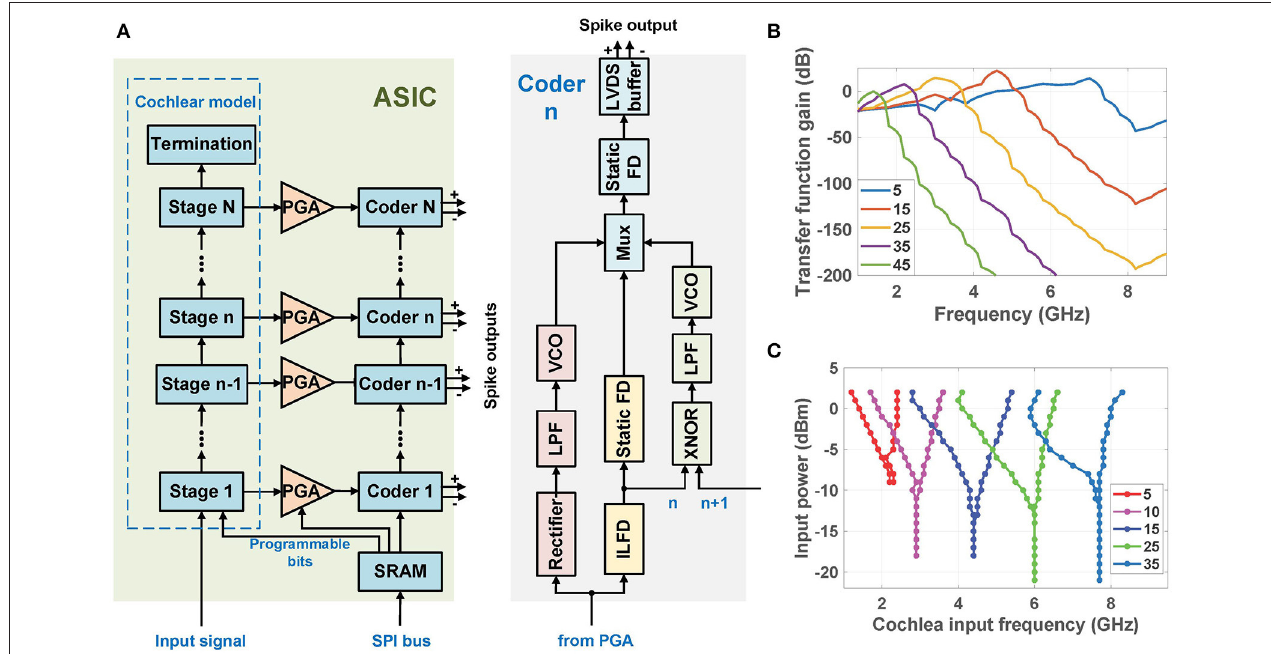
FIGURE 4 | (A) Simplified block diagram of the cochlea-based ultra-broadband RF spectrum analyzer chip (Wang et al., 2020). (B) Simulated small-signal spatial transfer functions of the amplitude encoders to continuous-wave (CW) inputs at stages { 5,15,25,35,45 } (Wang et al., 2020). (C) Simulated input sensitivity curves of the frequency and phase encoders (divide-by-3 ILFDs) at stages { 5,10,15,25,35 } .